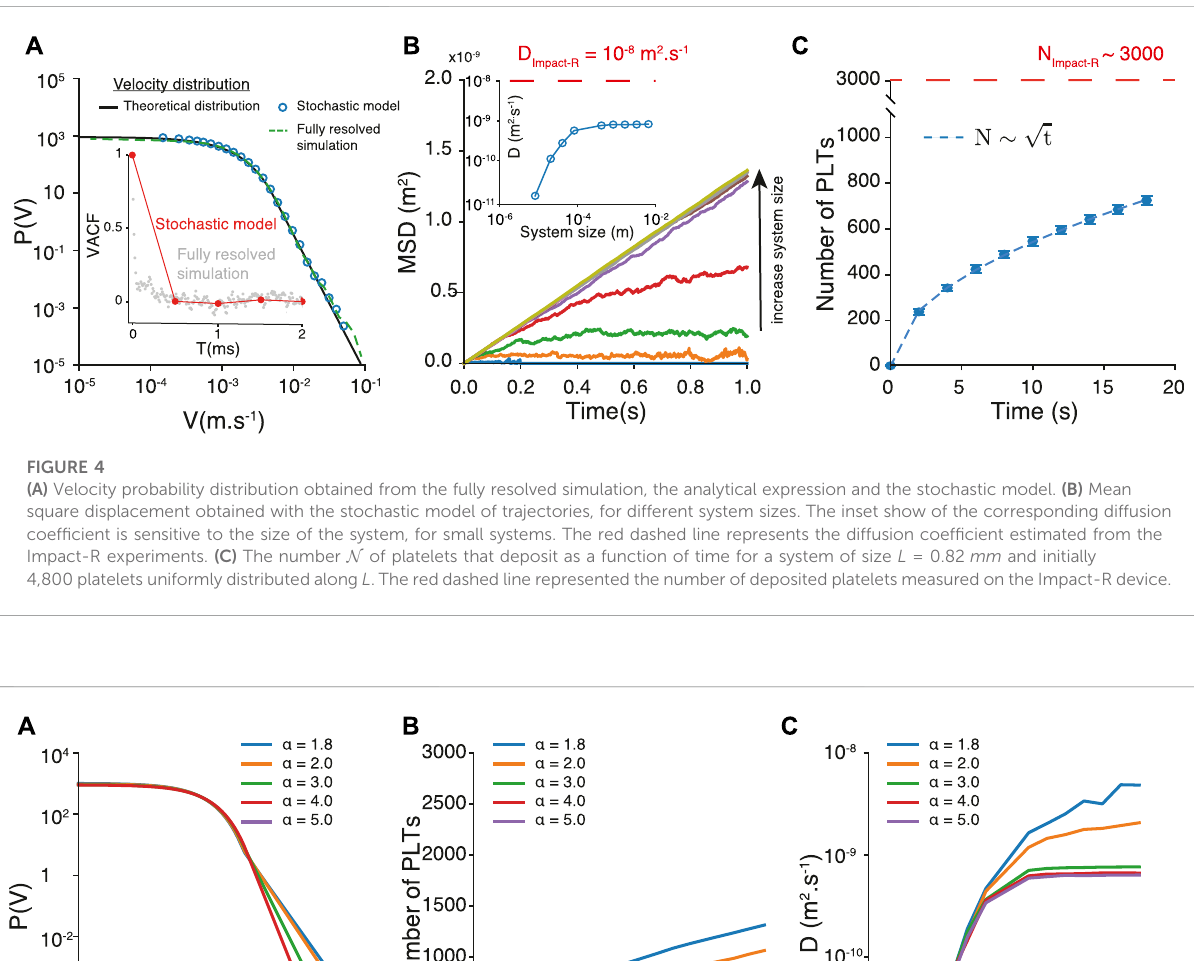
FIGURE 5 Velocity distribution, number of deposited platelets and fi nite size effect of the diffusion coef fi cient for different values of α (A – C) and different values of v moy and v min (D – F) . In Figures (D – F) , the orange curve represents our reference values of v moy and v min .